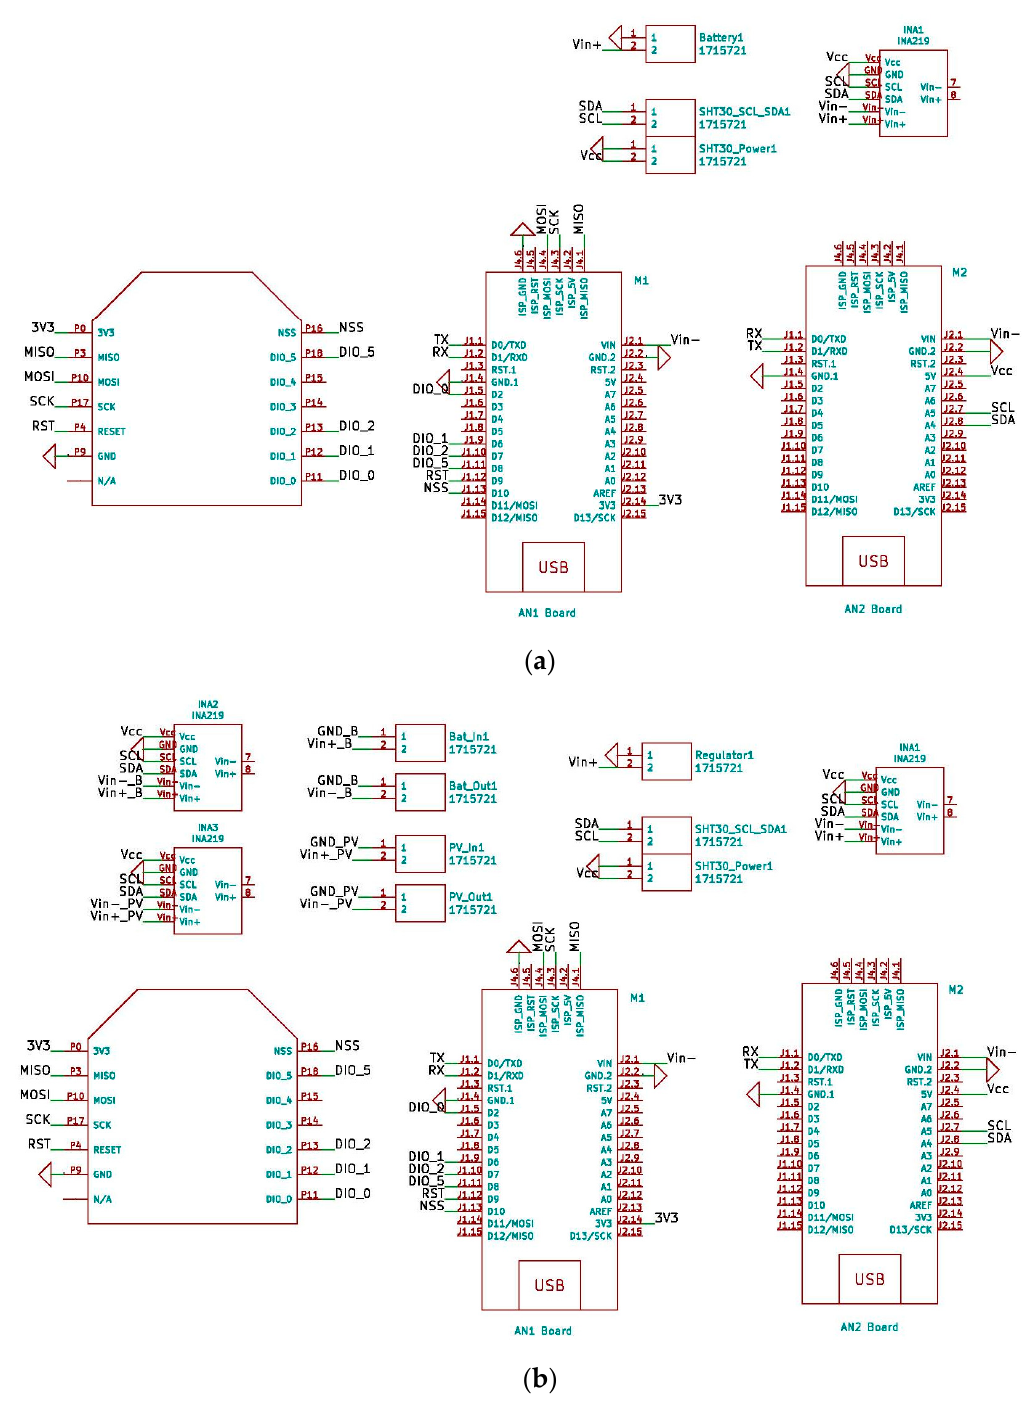
Figure 6. Schematic of the THMDL: ( a ) battery power supply and ( b ) battery and solar panel power supply.